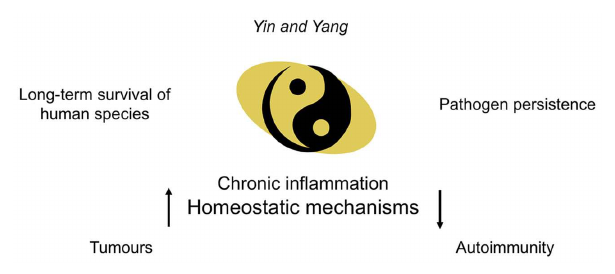
FIGURE 5 | Chronic inflammatory diseases as the “ Yin andYang ” of the immune system. Under conditions in which the immune system has been bypassed by persistent pathogens, chronic low-level inflammation guarantees long-term survival of the majority of infected individuals in spite of pathogen persistence.The imbalance of the homeostatic mechanisms maintaining chronic inflammation may degenerate into severe “side effects” (such as autoimmune disorders or tumors) in some individuals. However, these side effects are considered irrelevant in terms of the survival of the